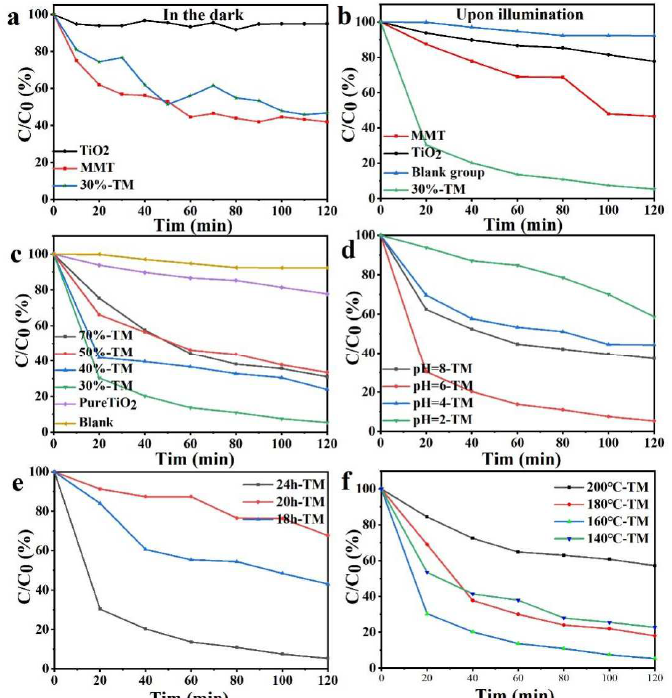
Figure 8. Methylene blue degradation curves obtained for ( a ) TiO 2 , montmorillonite (MMT), and 30%-TM under dark conditions; ( b ) the blank group, TiO 2 , MMT, and 30%-TM under visible light; ( c ) composites with different TiO 2 contents prepared at a reaction temperature of 160 °C, a dwelling time of 24 h, and a TiO 2 mass ratio of 30 wt%; ( d ) composites prepared at different pH values with a dwelling time of 24 h, a pH of 6, and a TiO 2 mass ratio of 30 wt%; ( e ) composites prepared with different dwelling times at a reaction temperature of 160 °C, a pH of 6, and a TiO 2 mass ratio of 30 wt%; and ( f ) composites prepared at different reaction temperatures with a dwelling time of 24 h, a pH of 6, and a TiO 2 mass ratio of 30 wt%.